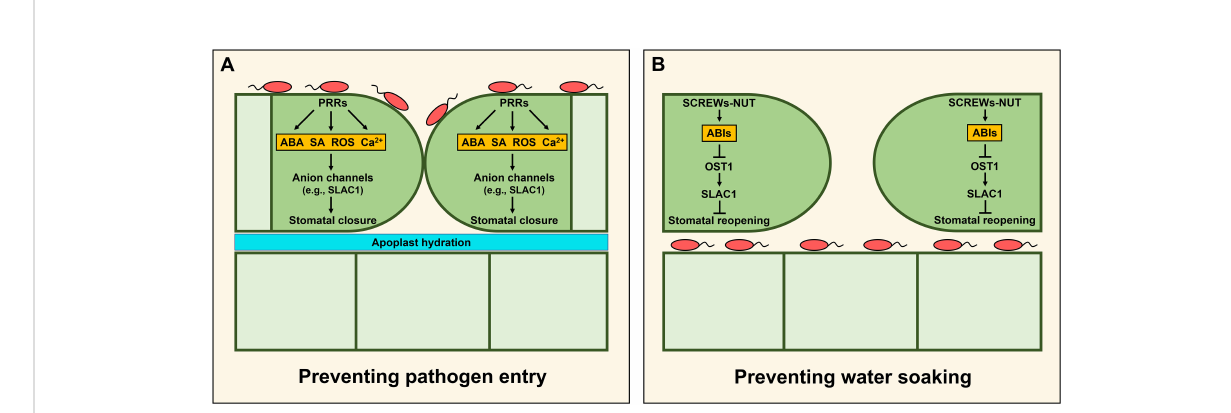
FIGURE 2 Stomatal immunity restricting pathogen entry or water soaking. (A) Pattern recognition receptors (PRRs)-triggered stomatal immunity. Recognition of pathogen-associated molecular patterns (PAMPs) by PRRs in guard cells promotes stomatal closure to prevent pathogen entry through activation of various signaling pathways such as ABA, SA, ROS, and Ca 2+ (Arnaud and Hwang, 2015; Murata et al., 2015). (B) Stomatal immunity preventing water soaking. After pathogens invade internal plant tissues, stomatal closure can confer apoplast hydration inducing pathogen colonization. To prevent it, the secreted peptides SMALL PHYTOCYTOKINES REGULATING DEFENSE AND WATER LOSS (SCREWs) and the cognate receptor kinase PLANT SCREW UNRESPONSIVE RECEPTOR (NUT) are induced in Arabidopsis. Recognition of SCREWs by NUT increases the activity of the protein phosphatases type 2C (PP2Cs) such as ABA INSENSITIVE 1 (ABI1) and ABI2, and it results in stomatal reopening through inhibition of OST1/SnRK2.6-SLAC1 module (Liu et al.,